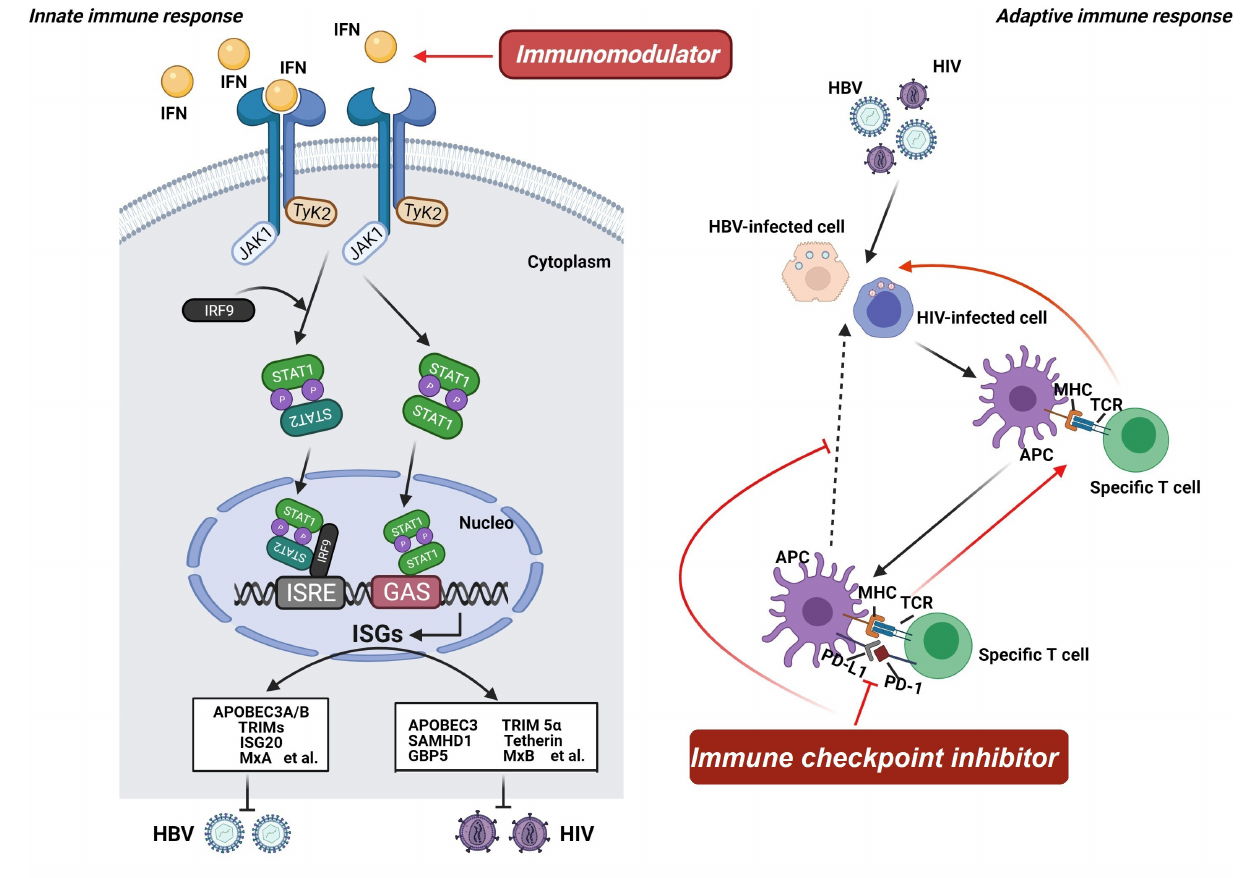
FIGURE 2 | Mechanism of host-targeted agents. Pattern-recognition receptors are activated when the virus invades, leading to the production of interferon (IFN). IFN interacts with its cognate receptors and activates receptor-associated kinases, contributing to the activation of the STAT family to form a transcription factor complex or a homo-/heterodimer. The transcription factor complex and the homo-/heterodimer bind to the ISRE and GAS promoter elements, respectively, and encode numerous viral restriction factors with potent inhibition potential on viral replication. Consequently, immunomodulators offer a rational option for treating HBV and HIV infection. Additionally, the adaptive immune response is also a promising target for novel therapeutic interventions owing to the key position of T cells in viral infection control. Regardless of HBV or HIV infection, virus-specific T cells have been found to have a distinct dysfunction. And the PD-1/PD-L1 axis plays an important role in the pathogenic process of viruses. Considering that high expression levels of PD-1 and PD-L1 are usually related to unsatisfactory immune response, agents based on the PD-1/PD-L1 axis might be able to reverse this immune suppression consequence and exert corresponding antiviral effects. Hence, immune checkpoint inhibitor targeting the PD-1/PD-L1 axis can be another option for treating HBV/HIV